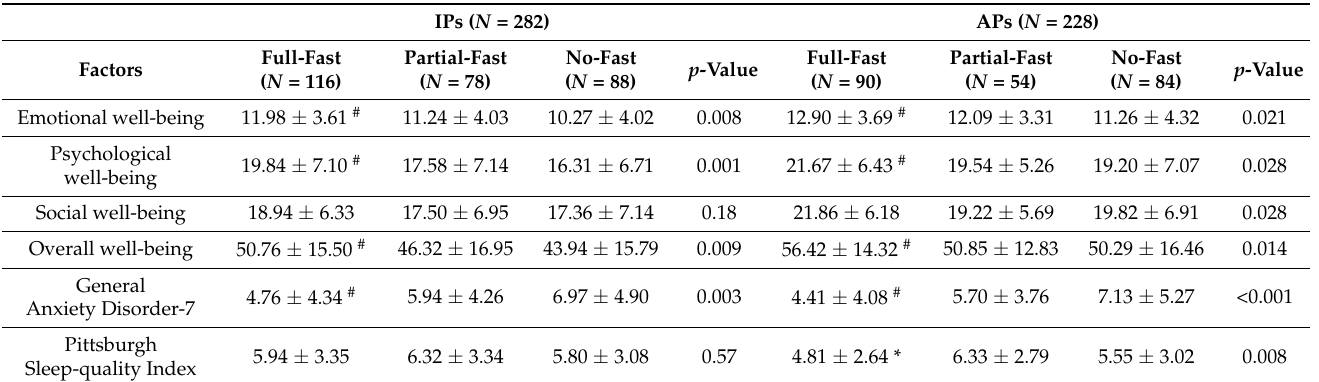
Table 4. Anxiety, well-being and sleep-quality outcomes based on fasting status. APs: active participants. IPs: inactive participants. N : number. Data were mean ± standard deviation. All data were analyzed using one-way ANOVA followed by Bonferroni’s post hoc test. * Significant difference compared with the partial fast state; # Significant difference compared with the no fast